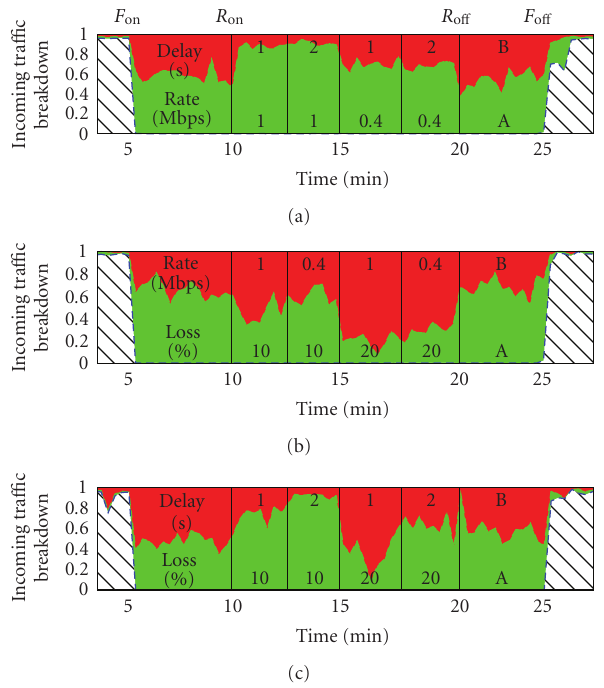
Figure 4: Pathwise metrics: combined impairments, considering RTT delay versus bottleneck bandwidth (a), bottleneck bandwidth vresus packet loss (b), RTT delay versus packet loss (c). Relative importance of impairments depends on their actual